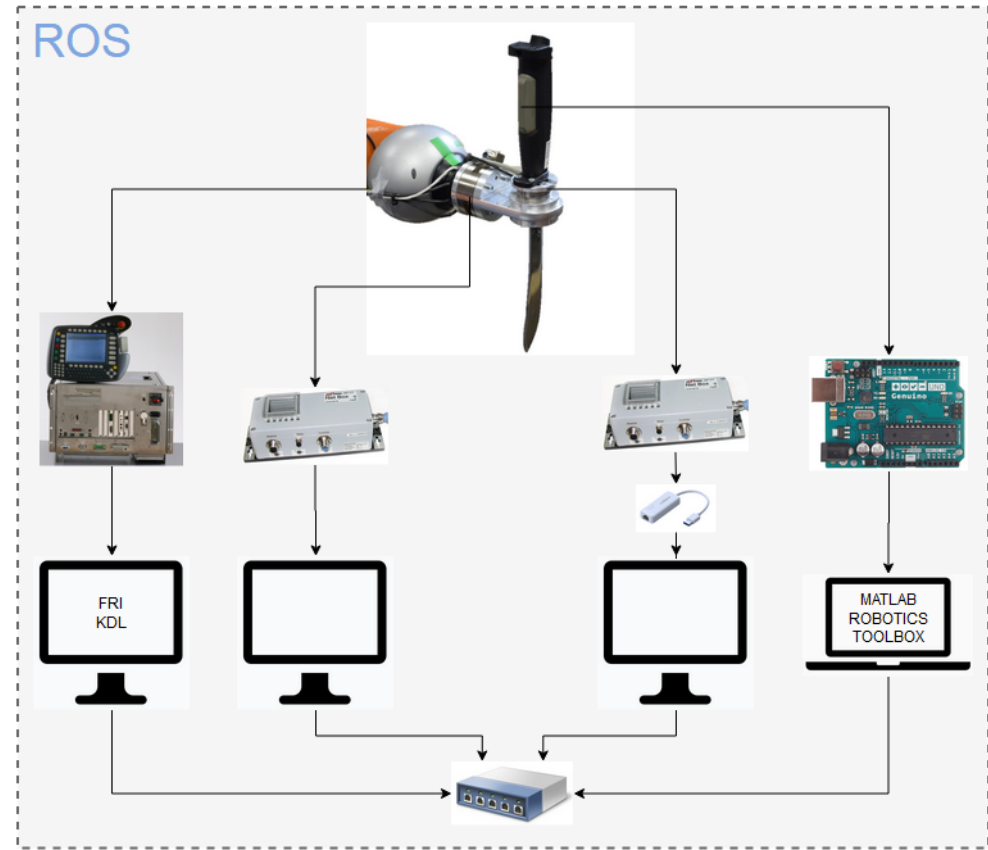
Figure 14. Network diagram of the Exoscarne system. From left to right: control box of the KUKA LWR 4+ robot connected to one PC with FRI/KDL libraries; data acquisition boxes for FT sensors A and B connected to two PCs and an Arduino board for joystick acquisition connected to a